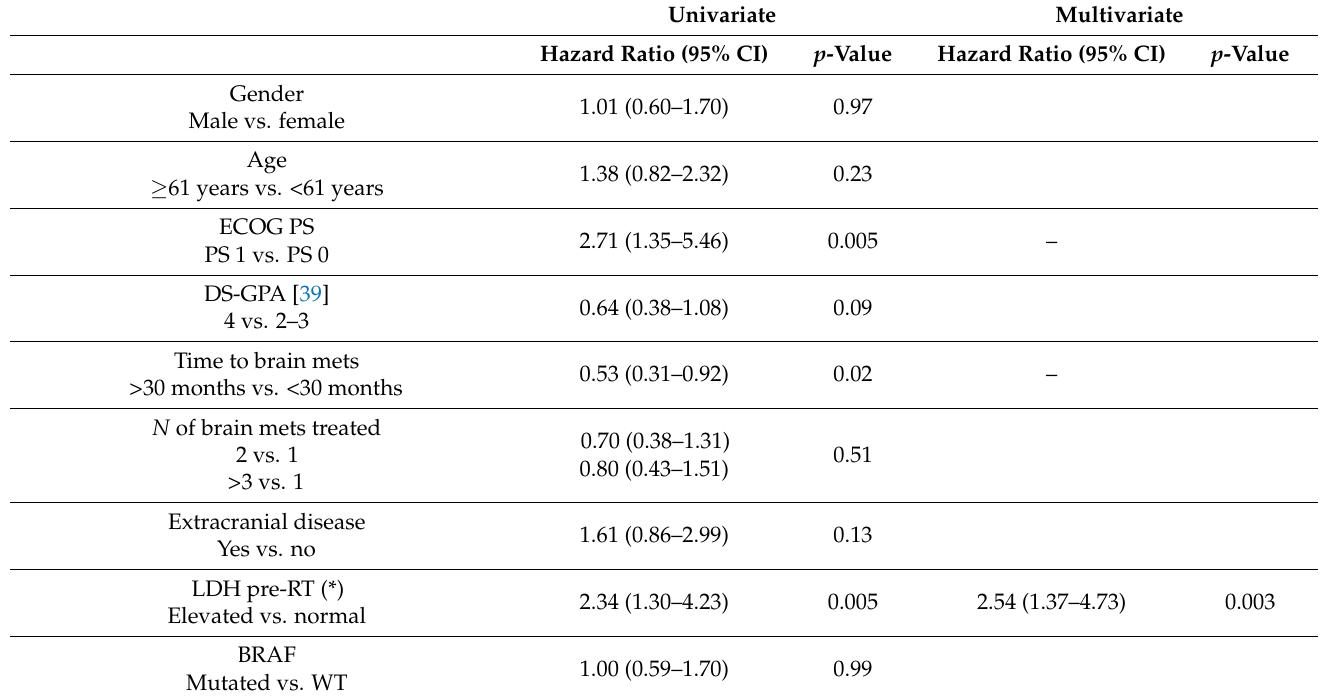
Table 3. Univariate and multivariate analysis for overall